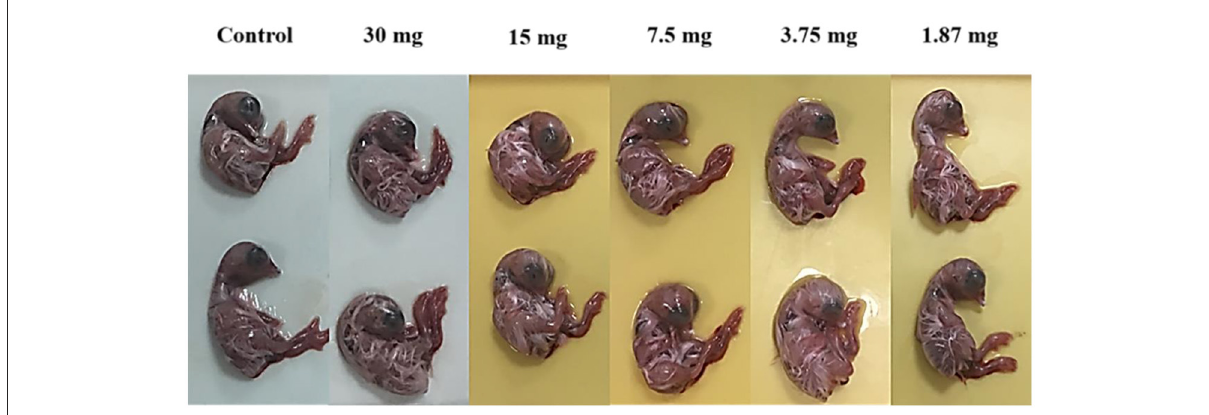
FIGURE6 Effect of biosurfactants (at different doses for 48h) on size and aspect of chicken embryos.